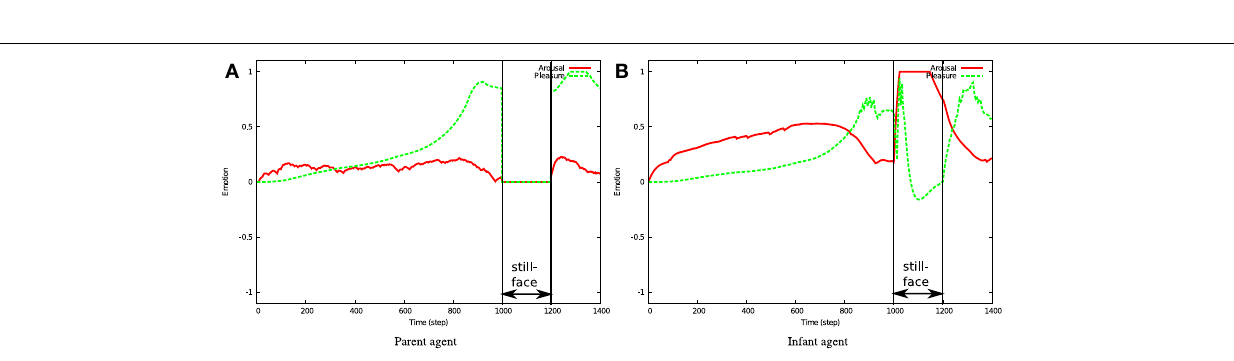
FIGURE 11 | Emotional states during simulated still-face interactions. Red and green lines indicate the arousal and pleasure levels, respectively. (A) Parent agent. (B) Infant